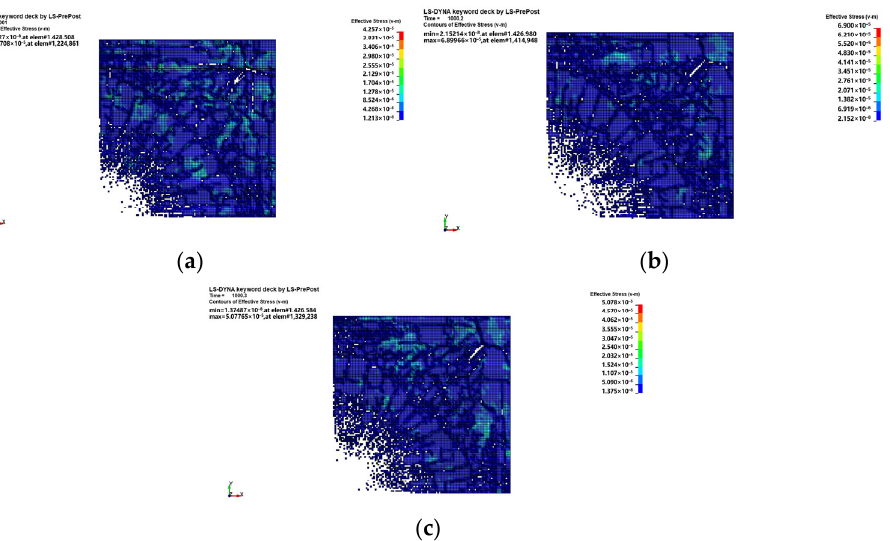
Figure 3. ( a ) Top ignition; ( b ) central ignition; ( c ) bottom ignition.